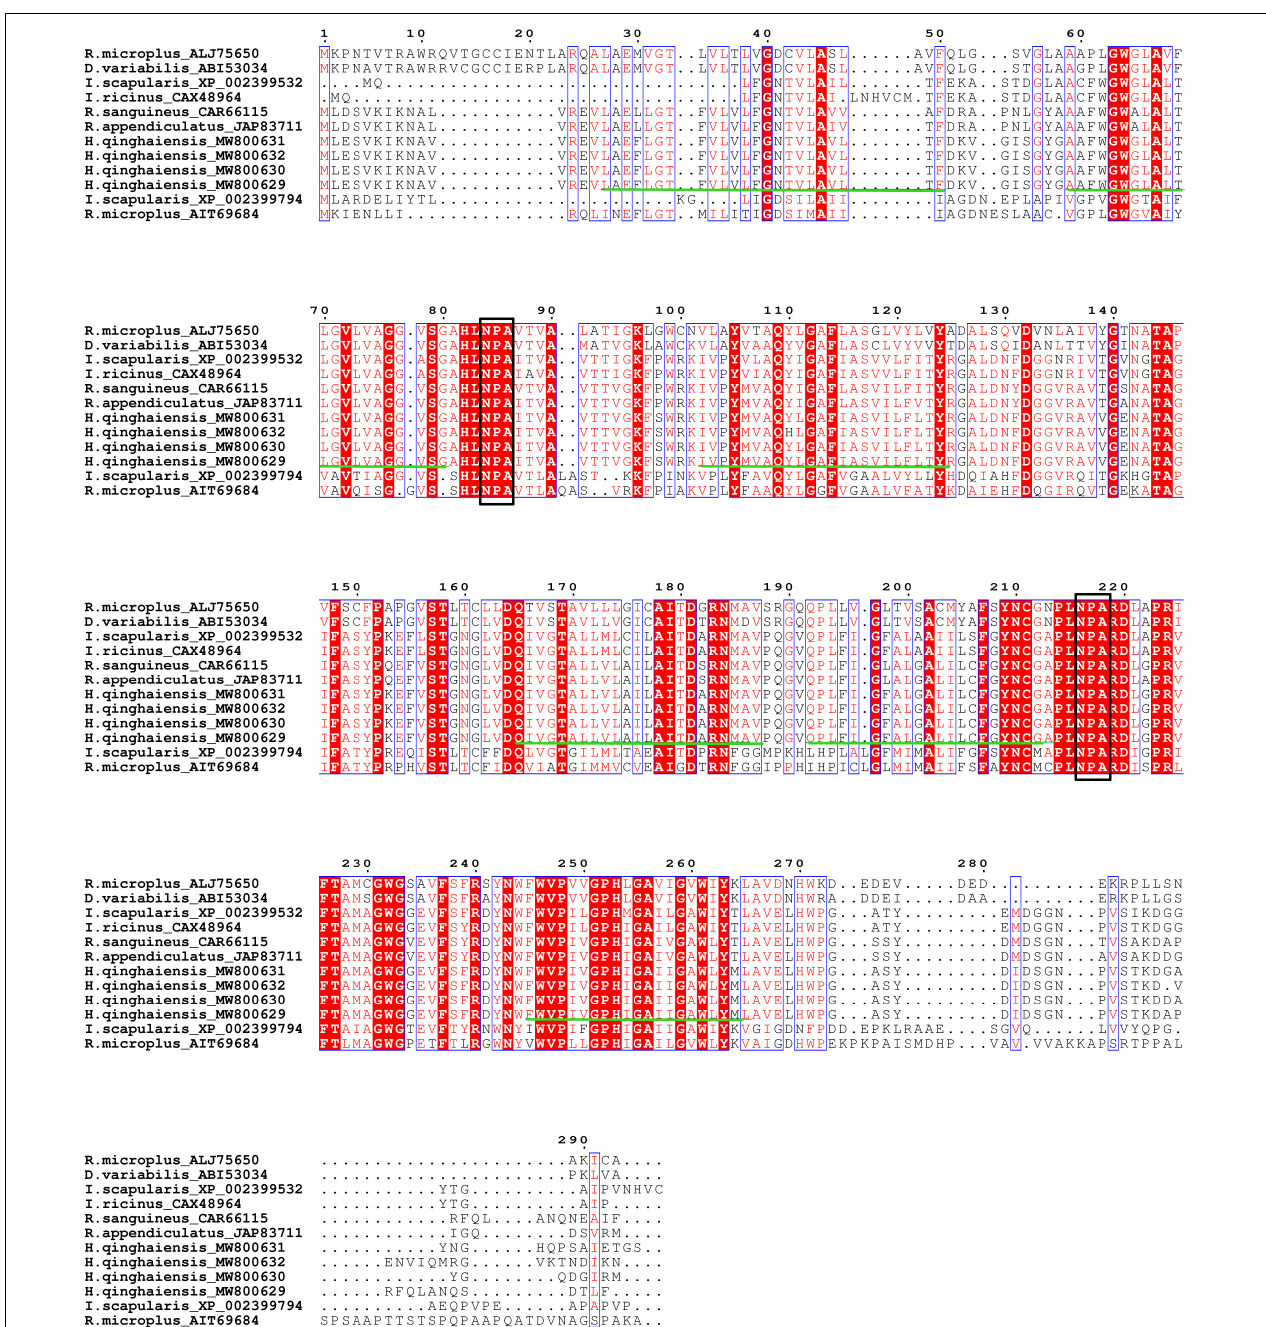
FIGURE 2 | Alignment of predicted amino acid sequences of four H. qinghaiensis aquaporin transcript variants with reported other tick AQPs. Protein accession numbers and tick species are shown for each sequence. The two NPA motifs (asparagine-proline-alanine [Asn-Pro-Ala]) are boxed. The six transmembrane regions are indicated with green